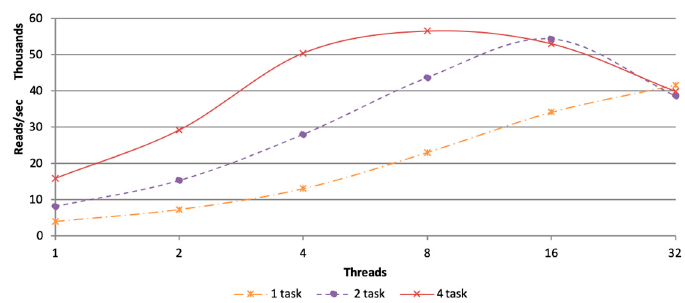
Figure 7. Alignment speed of different pairs of thread count and task count. Throughput of different pairs of thread count and task count, four tasks with eight threads bring about the highest performance.